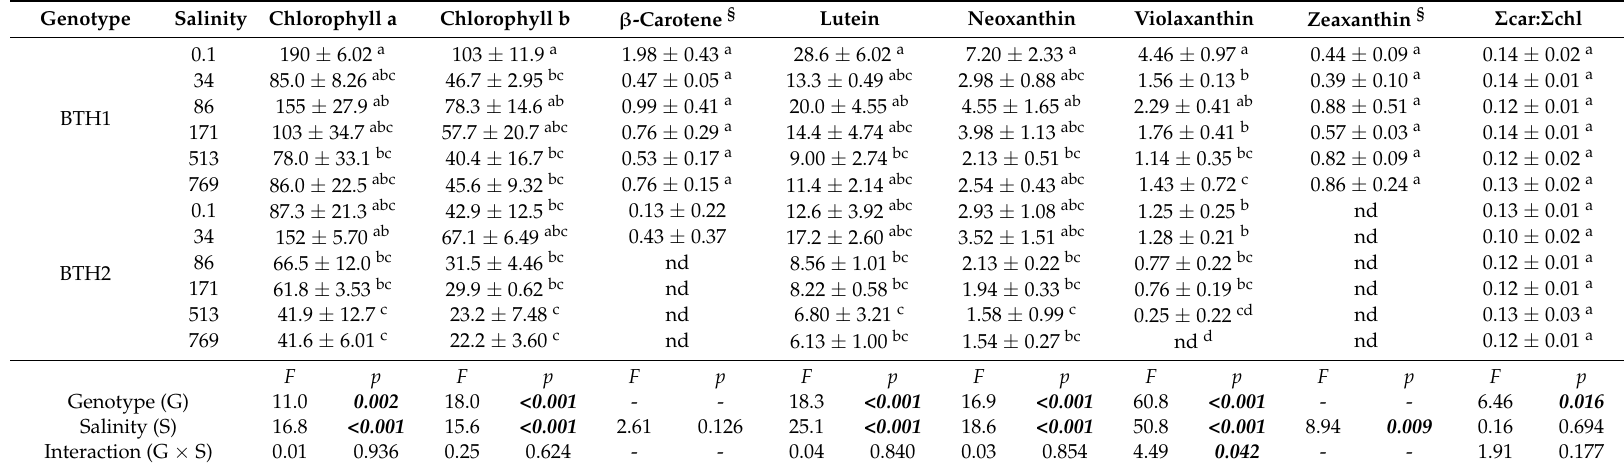
Different lowercase letters (within a column) represent significant differences between the averages ( p < 0.05), according to the Tukey’s HSD test. § , Oneway ANOVA was applied to evaluate salinity effect on BTH1 genotype because of the occurrence of non-detected (nd) values for BTH2 genotype shoots in most of salinities levels tested. Σ car: Σ chl is the